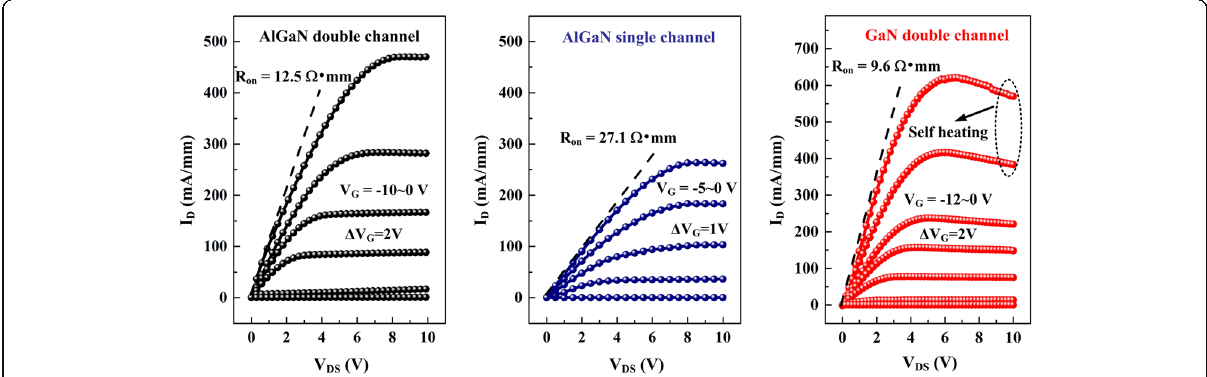
Fig. 5 Output characteristics of AlGaN double channel, AlGaN single channel, and GaN double channel